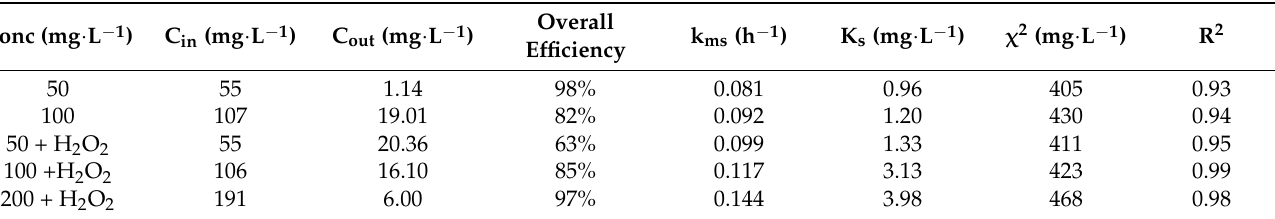
Table 5. Kinetic parameter estimation for the biological reactor at different initial concentrations using AQUASIM (Michaelis-Menten model).